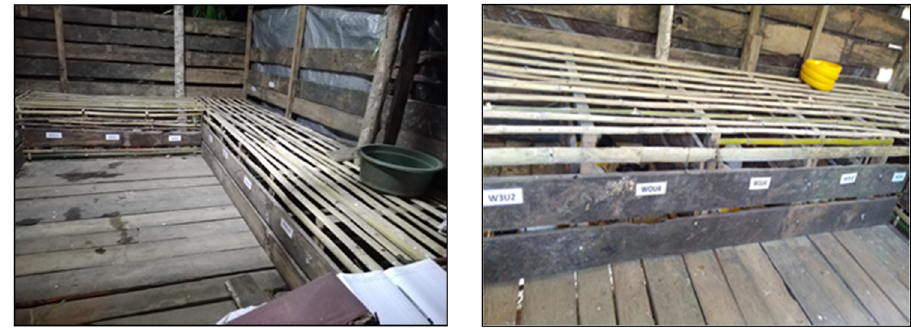
Figure 1: Design of an experimental plot fi lled with fi ve native